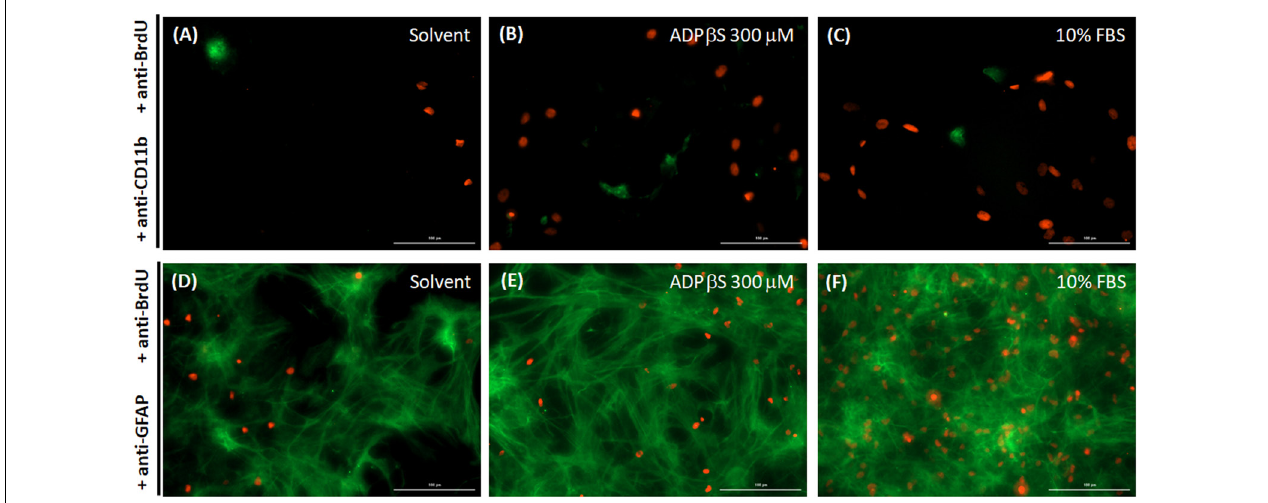
FIGURE 2 | BrdU staining and its cellular localization in astrocyte cultures. Astrocyte cultures were incubated with solvent (A,D) , ADP β S (B,E) or 10% FBS, a positive control for cell proliferation (C,F) , for 48 h. BrdU (100 µ M) was added to the medium for the last 24 h and then stained with rabbit anti-BrdU (Alexa Fluor 594, red) to visualize BrdU incorporation. Microglia were then co-labeled with mouse anti-Cd11b ( A–C ; Alexa Fluor 488, green) and astrocytes, with mouse anti-GFAP ( D–F ; Alexa Fluor 488, green). BrdU positive nuclei co-localize mainly with astrocytes, showing they are the main proliferating cells within the astrocyte cultures. Representative images from 3 different cultures. Scale bar: 100 µ m.